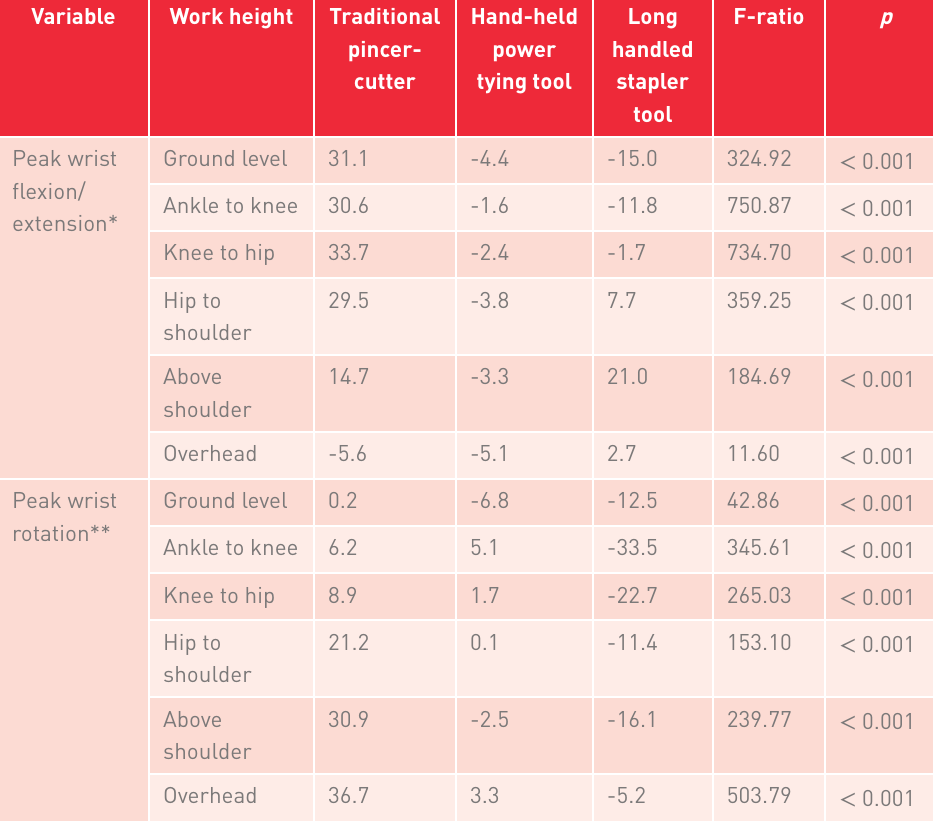
*Positive values indicate wrist flexion. Negative values indicate wrist